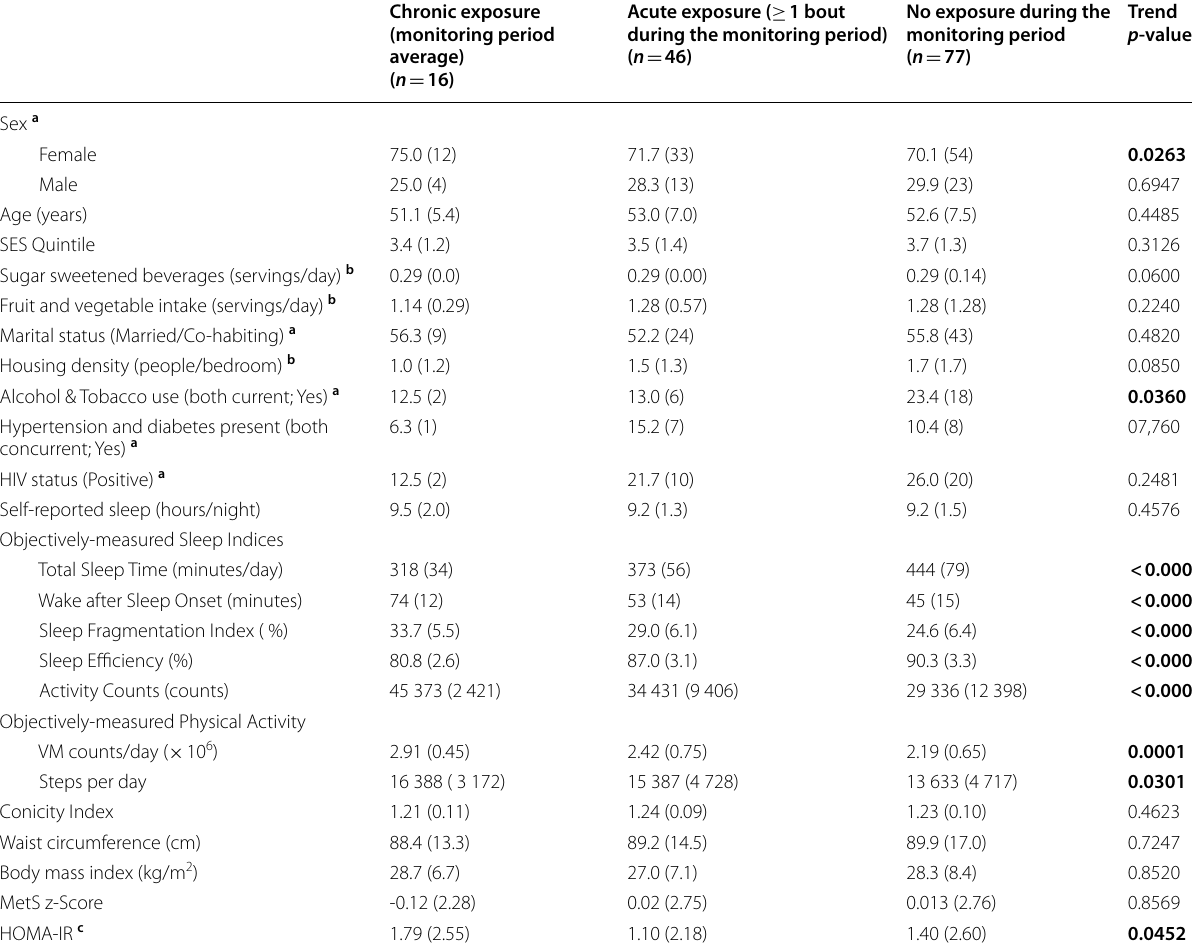
Table 2 Descriptive statistics by level of exposure to short, fragmented